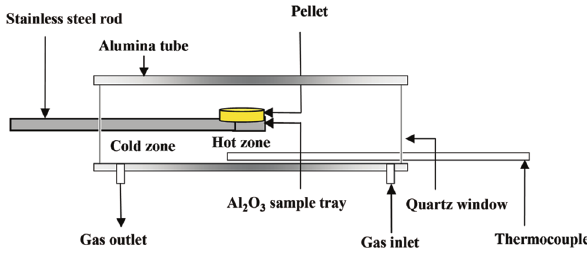
Figure 1: A schematic representationoftheexperimentalarrangement.